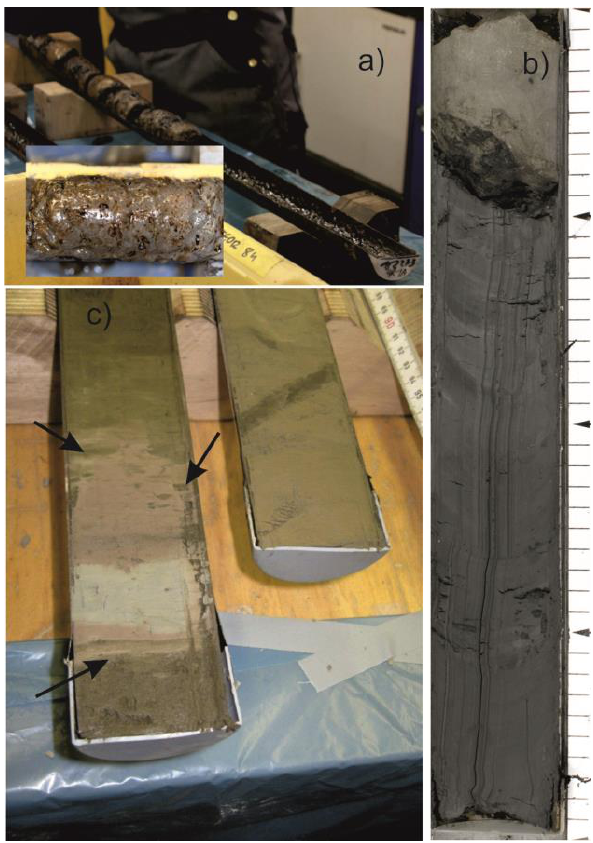
Fig. 6. High-quality cores drilled with the MeBo from massive gas hydrate layers (a) , and hemipelagic muds containing authigenic car- bonate precipitates (b) and ash layers (c) . Arrows point to sharp Figure 6. High quality cores were drilled with MeBo from massive gas hydrate layers (a), and 3 contact at the base of the ash layer and bioturbation structures at the top, which are indicators of minimum disturbance of the sediments hemipelagic muds containing authigenic carbonate precipitates (b) and ash layers (c). Arrows 4 during drilling. (photos: Marum). point to sharp contact at the base of the ash layer and bioturbation structures at the top which 5 are indicators of minimum disturbance of the sediments during drilling. (Photos: Marum). 6